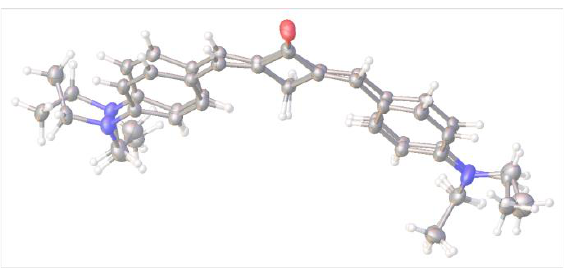
Figure 3. Superposition of independent molecules (A and B) in crystal structure 1f.